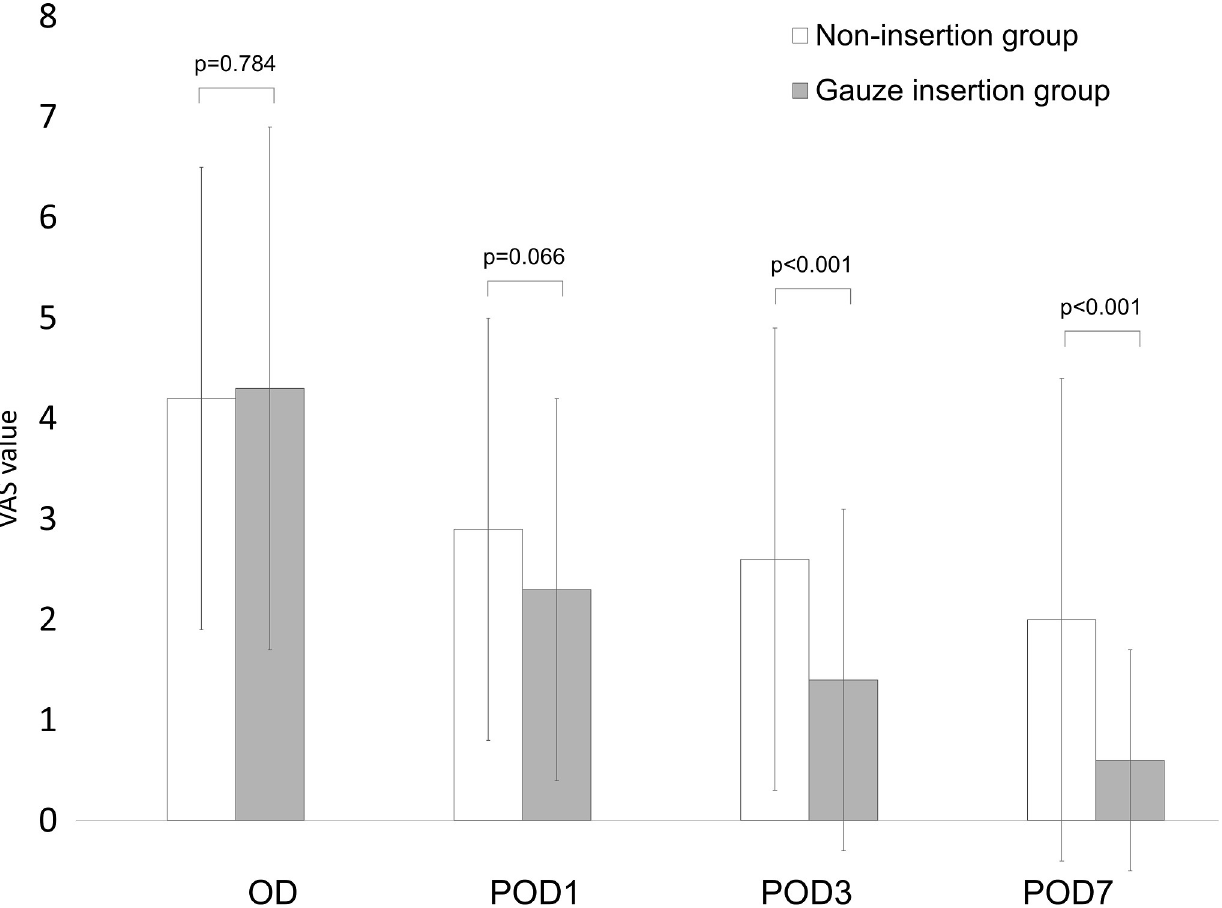
Fig 2. Changes in VAS value after tooth extraction in the gauze-insertion and non-insertion groups. Spontaneous post-extraction pain was assessed using a visual analogue scale (VAS) ranging from 0 (no pain) to 10 (worst pain) on four occasions: the operative day, postoperative day 1 (POD1), POD3, and at suture removal (POD7). Error bar indicates standard deviation. P-values were calculated using the Wilcoxon rank-sum test. Abbreviations: OD, operative day; POD1, postoperative day 1; POD3, postoperative day 3; POD7, postoperative day 7; VAS, visual analogue scale.